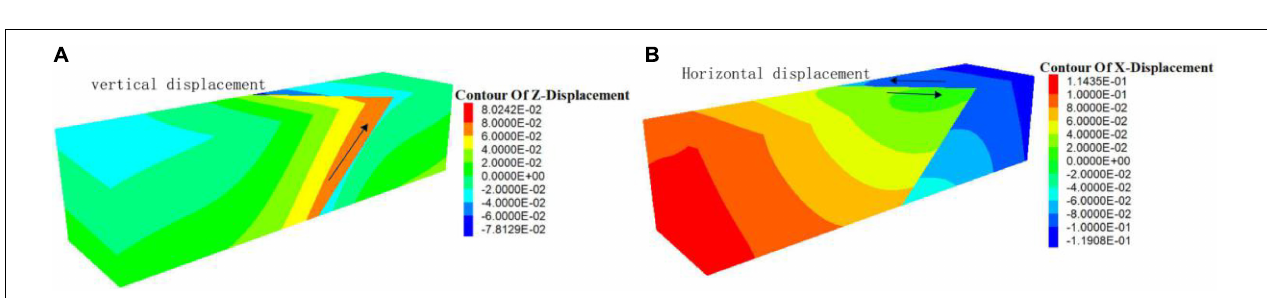
FIGURE 3 | Fault slip simulation under different schemes. The simulation scheme is listed in Table 1 , and (A) shows that the fault of simulation scheme 1 has no dislocation, (B) shows that the fault of simulation scheme 2 has no dislocation, (C) shows that the fault of simulation scheme 3 has no dislocation, (D) shows that the fault of simulation scheme 4 has dislocation, (E) shows that the fault of simulation scheme 5 has dislocation.